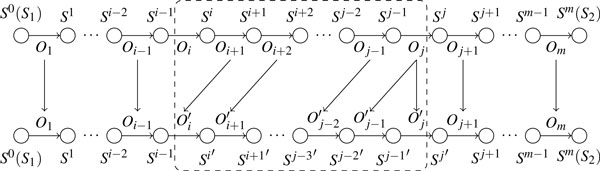
Building a new series of operations to replace OiOi+1⋯Oj. Oi will be skipped and Ok′ will mimic Ok + 1for k = i, i +1, ..., j -2. Finally, Oj-1′ and Oj will be constructed according to Oj.